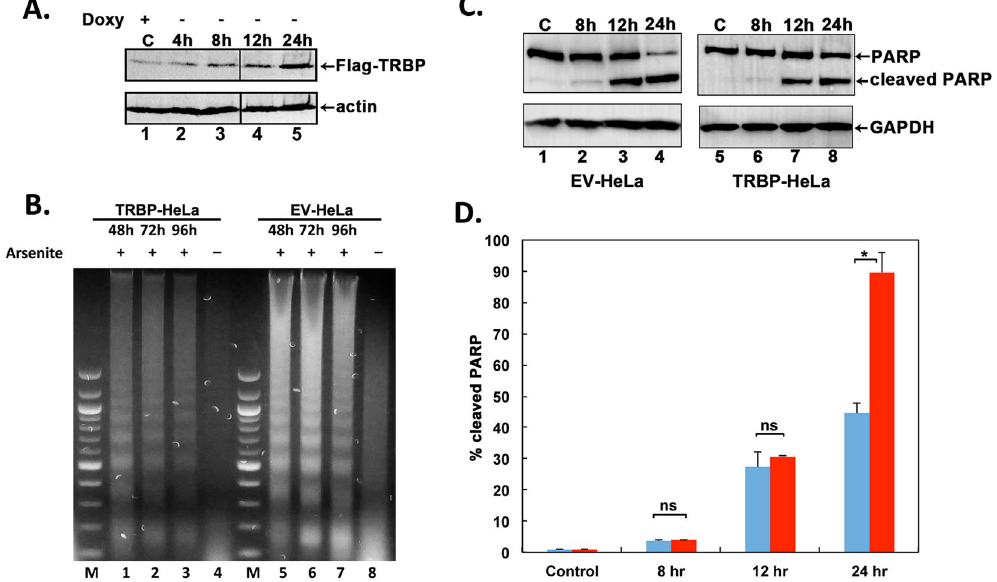
Figure 1. TRBP overexpression protects cells from arsenite-induced apoptosis. ( A ) Establishment of a stable doxycycline-inducible HeLa cell line overexpressing flag-TRBP. HeLa-Tet off (Clontech) cells were transfected with either FlagTRBP/pTRE2pur expression construct or pTRE2pur (Clontech) empty vector (EV). Puromycin resistant clones were isolated, characterized, and one clone (TRBP-HeLa) that showed inducible expression of FlagTRBP was selected for further studies. Induction of FlagTRBP expression after removal of doxycycline from the growth medium at indicated time points is shown. Western blot analysis of cell lysates using 50 μ g of total protein was performed using anti-Flag and anti- β -actin antibodies. The black line between lanes 3 and 4 represents where different lanes from the same western blot were joined. ( B ) DNA Fragmentation Analysis. TRBP-HeLa cells overexpressing FlagTRBP (Lanes 1–4) or EV-HeLa control cells (Lanes 5–8) were treated with 10 μ M sodium arsenite for 48, 72, and 96 hours, fragmented DNA was isolated and analyzed. M: 100-bp ladder, Lanes 1 & 5: 48 hr treatment. Lanes 2 & 6: 72 hr treatment, Lanes 3 & 7: 96 hr treatment, and Lanes 4 & 8: untreated cells. ( C ) Analysis of PARP cleavage in response to arsenite treatment. TRBP-HeLa and EV-HeLa cells were treated with 25 μ M sodium arsenite for the indicated time points, and western blot analysis using anti- PARP antibody was performed on cell lysates containing 50 μ g of total protein to assess increases in poly ADP- ribose polymerase (PARP1) cleavage. Western blot was also performed with anti-GAPDH antibody to ensure equal protein in all samples. ( D ) Quantification of PARP cleavage. PARP1 and cleaved PARP1 bands were quantified using ImageQuant TL Software. The percentage of cleaved PARP1 was calculated as (cleaved PARP1 band intensity/cleaved + uncleaved bands intensities) X 100. Bars represent percentages of cleaved PARP1 from 3 independent experiments. Error bars represent standard deviation (S.D.) from three experiments. Student’s t tests were performed to determine statistical significance – ns: not significant, asterisk: p value of